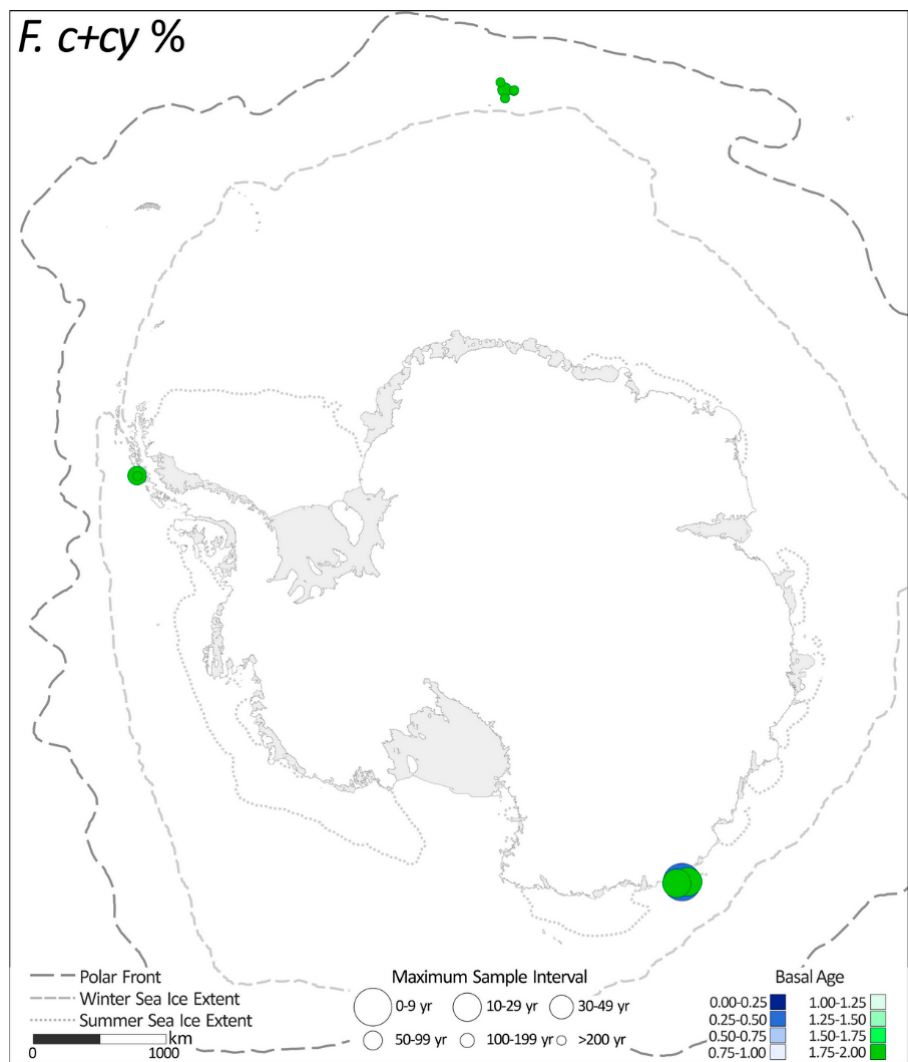
Figure 2. Map showing cores sites where F. c + cy % is used to reconstruct sea ice conditions. The symbol size reflects the resolution of the record and the color of the symbol indicates the basal age of the record between 0 and 2 ka BP. Table 4. Summary information on the ages, resolution and proxy types of all sites.